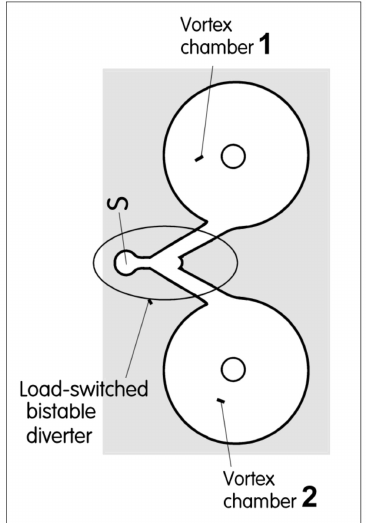
Figure 26. Switching the jet to the opposite attachment wall (from output 1 to output 2 ) by the load that makes the flow into the output 1 more di ffi cult. Adapted from Reference [27].